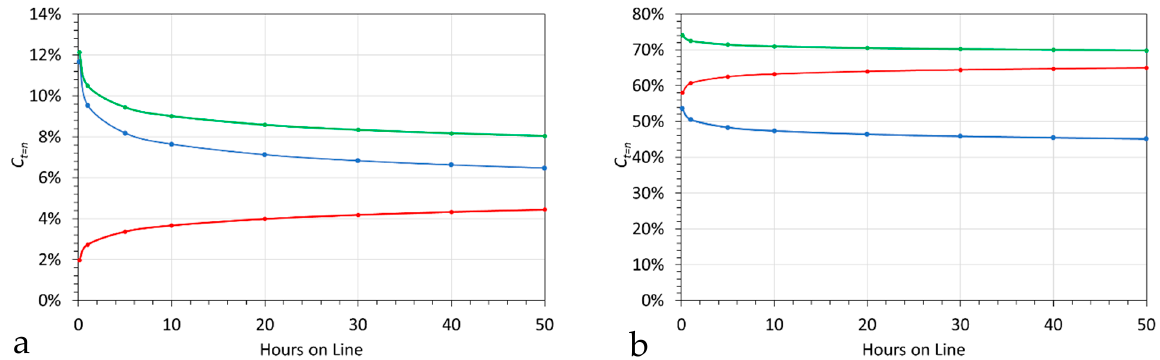
Figure 10. Removal of ions Fe@Ca@Mn@HCOOH polymer; ( a ), chloride; ( b ), sodium; red line = + tartaric acid; blue line = + malic acid; green line = + citric acid.